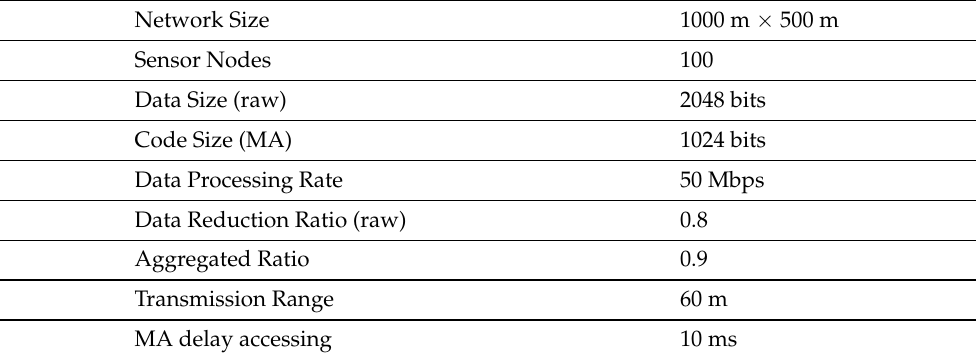
Table 2. Simulated Parameters for the Proposed GDMIP Approach.